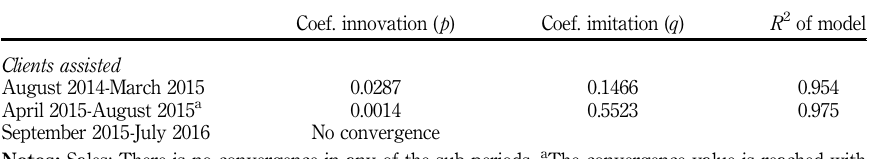
Table IV. NLLS estimation for the C4 Cactus for the three sub